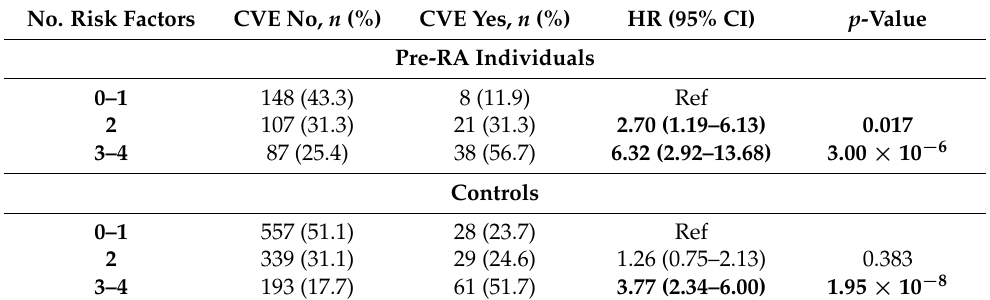
Table 4. Risk for CVE a stratified on number of CVD b risk factors c in pre-RA subjects and